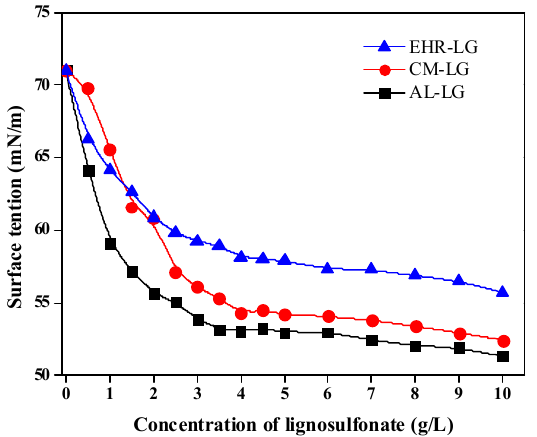
Figure 2. Surface tension of the lignosulfonates AL-LG, EHR-LG, and CM-LG in solutions of different concentrations.